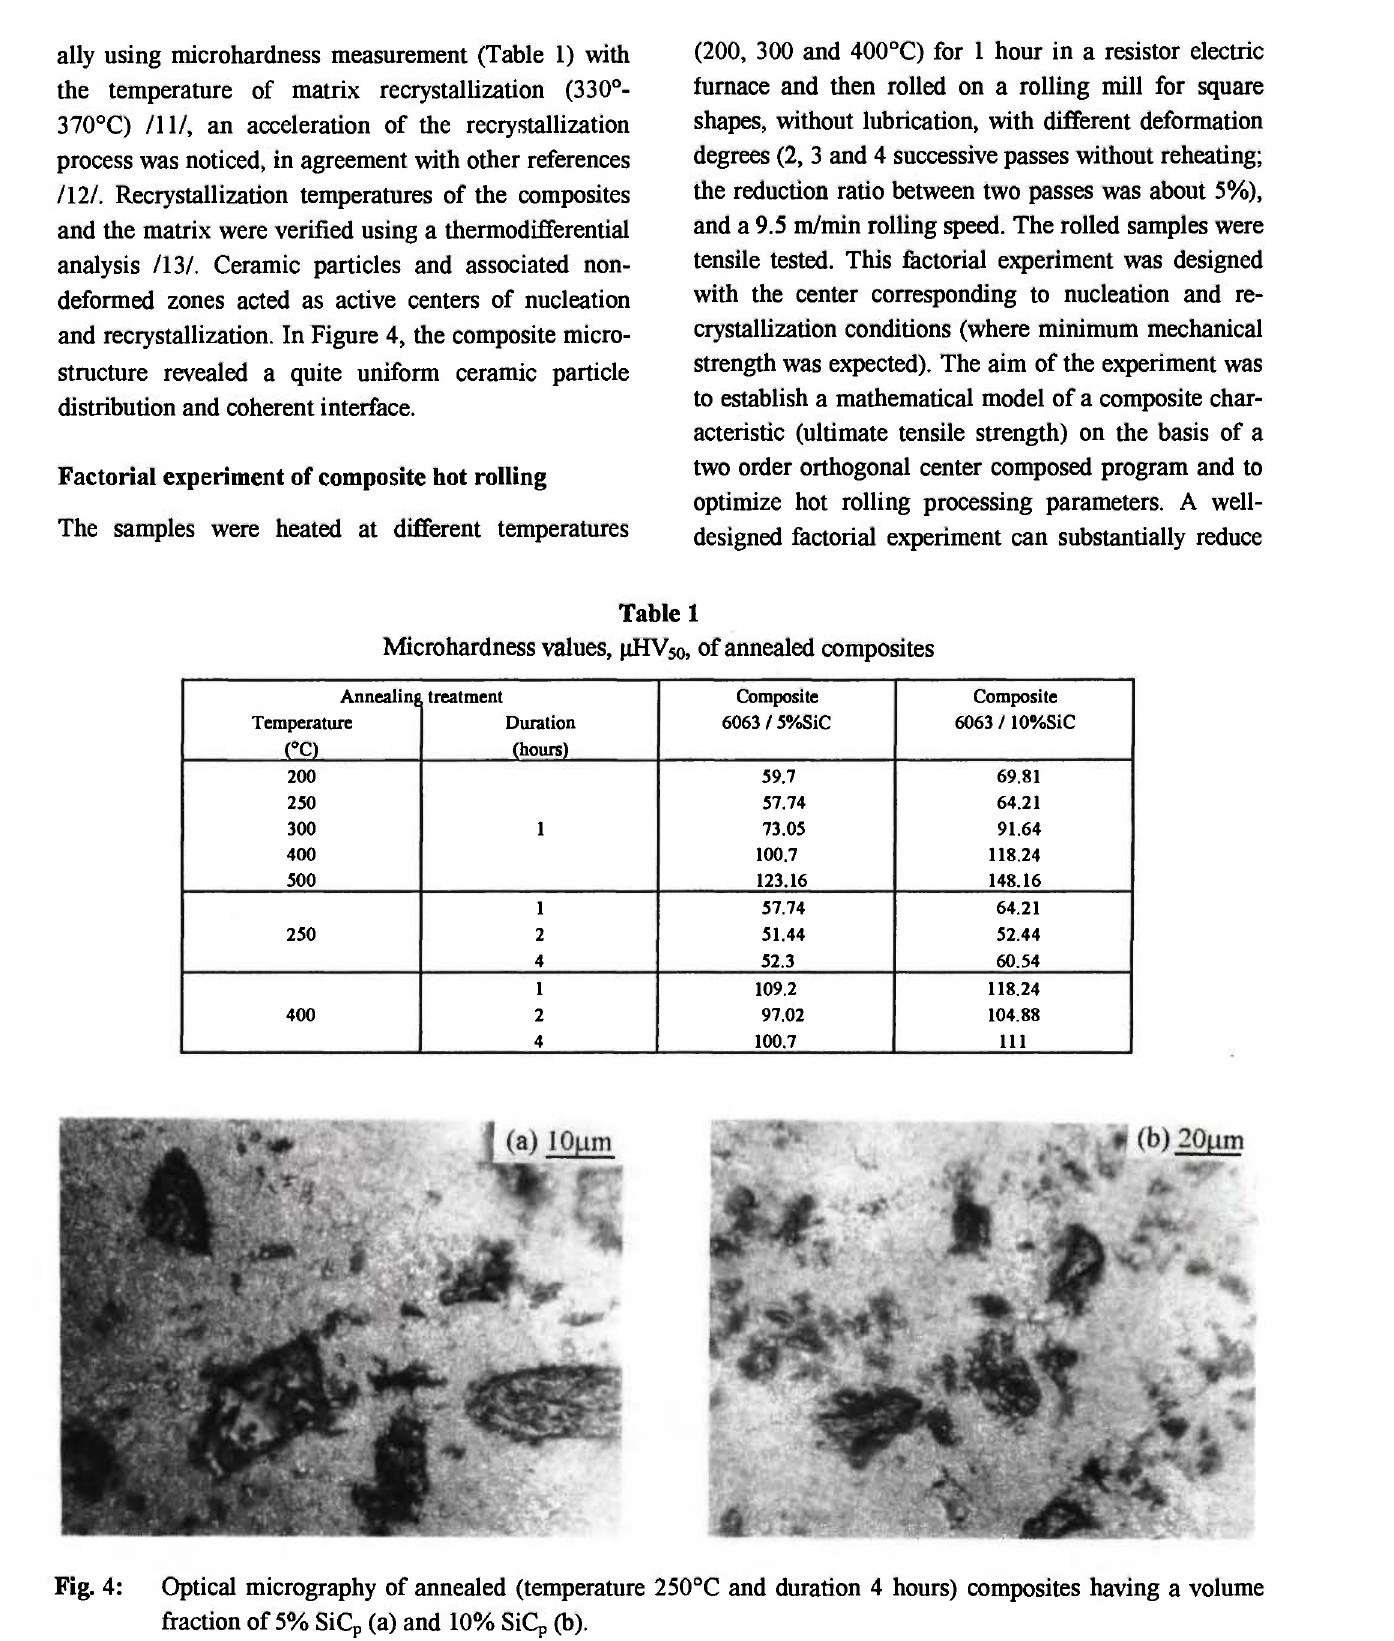
Fig. 4: Optical micrography of annealed (temperature 250°C and duration 4 hours) composites having a volume fraction of 5% SiC (a) and 10% SiCp p